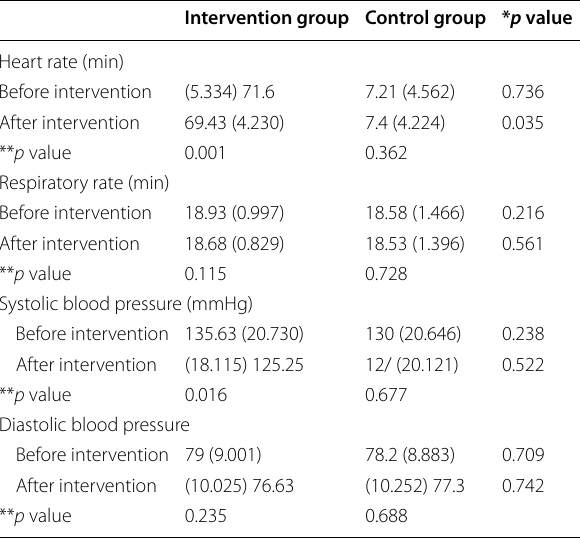
*Independent samples T